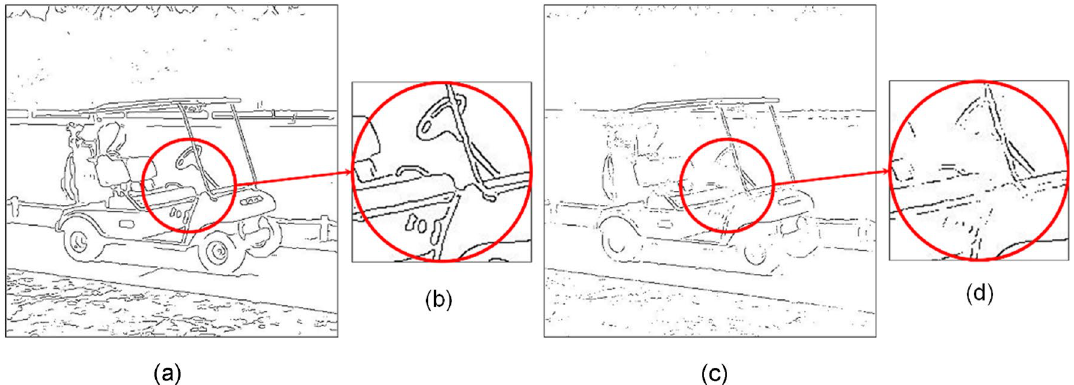
Figure 10. ( a ) k = 0.5, (MQ, EQ, FoM) = ( 0.87, 0.84, 0.80). ( b ) Close-up for the encircled area in ( a ). ( c ) k =